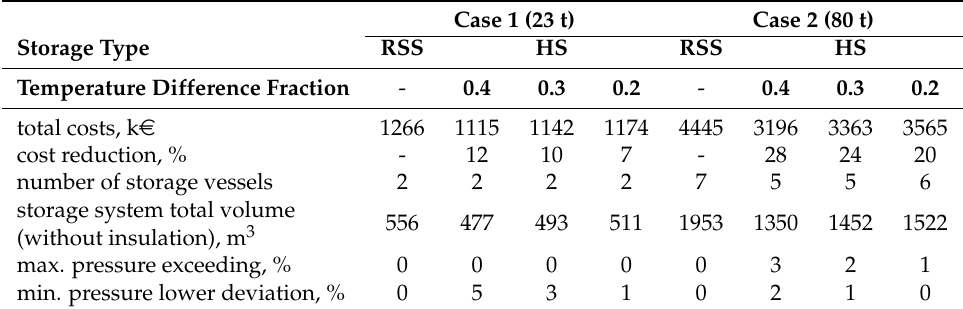
Table 8. Results of the storage design optimization and results of the verification with a dynamic simulation